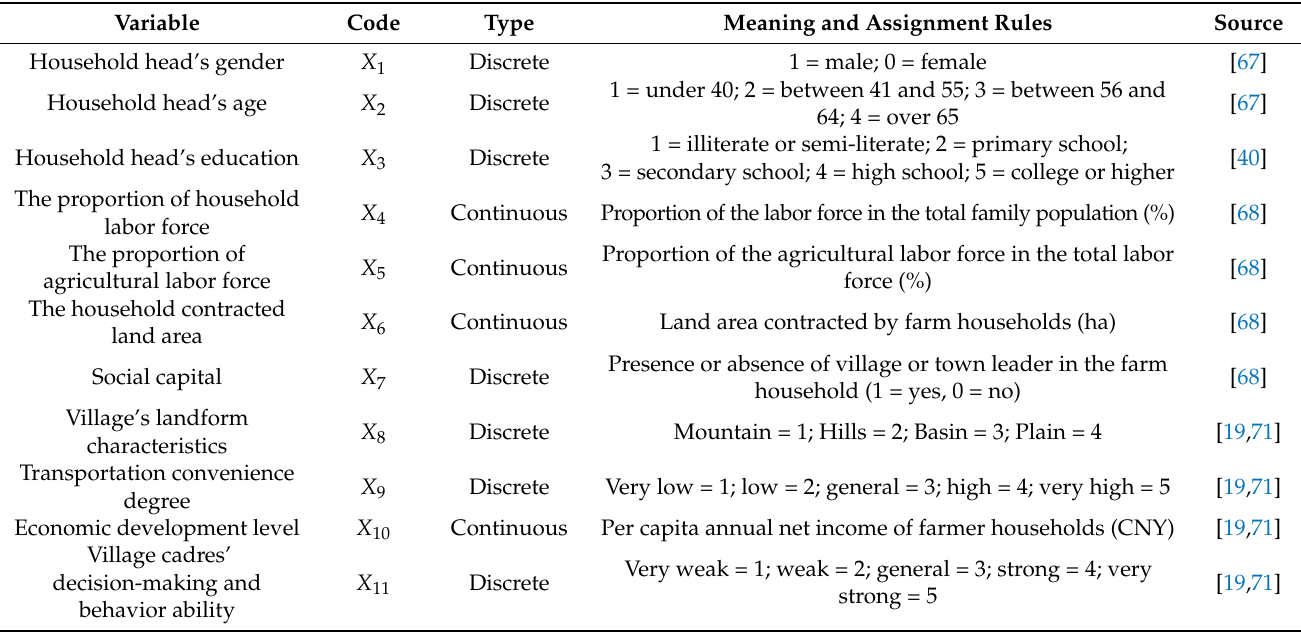
Table 2. Control variables and their code, definition, and assignment